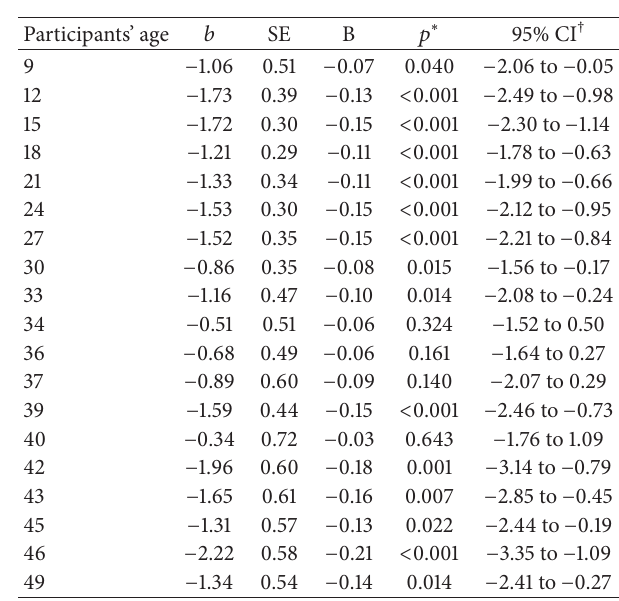
Table 2: Physical activity factor scores (assessed at participants’ ages from 9 to 49) as predictors of symptoms of depression (participants aged from 35 to 50) ( 𝑛 = 255 –1467).